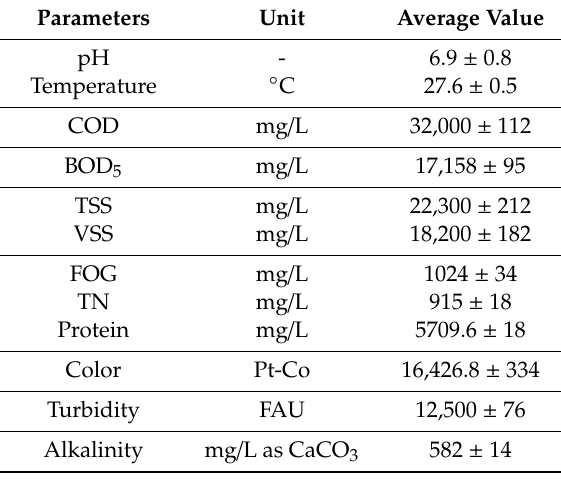
Table 1. Characteristics of the cattle slaughterhouse wastewater (CSWW) used in this